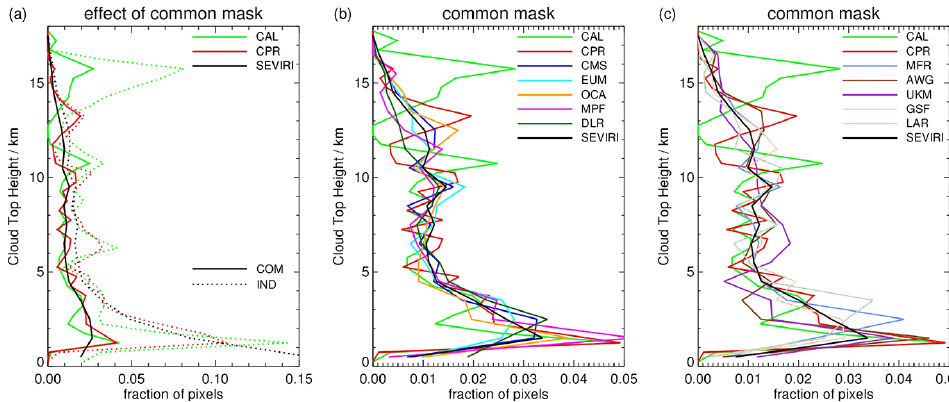
Figure 6. Histograms of the CTH for 13 June 2008, 12:00–15:30UTC (A-train overpasses 11317–11319). Panel (a) shows the histograms of the complete CALIOP and CPR data set and the average of the SEVIRI algorithm histograms as dotted lines. The histograms using the common mask filtering are shown as solid lines. In panels (b) and (c) , the histograms of the individual algorithms are shown using the common mask filtering. For multi-layer cloud situations only the uppermost CTH is considered.